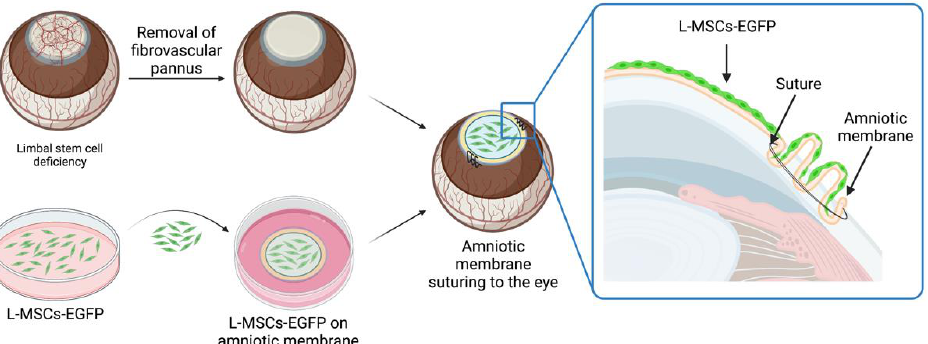
Figure 1. Schematic representation of the tissue-engineered graft preparation and transplantation. Before the transplantation, the fibrovascular pannus was removed from the corneal surface. Decellularized human amniotic membrane (dHAM) with cultured L-MSCs-EGFP was placed on the de-epithelialized corneal stroma with the cells facing up and sutured to the episclera. dHAM was folded across the whole limbus to provide an additional physical barrier and delay conjunctivalization of the cornea after surgery. Created with BioRender.com.